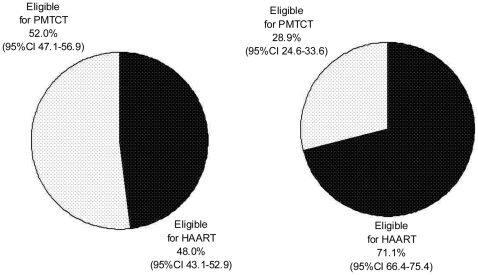
Using CD4 Count to guide clinical management of HIV positive pregnant women (n = 630).